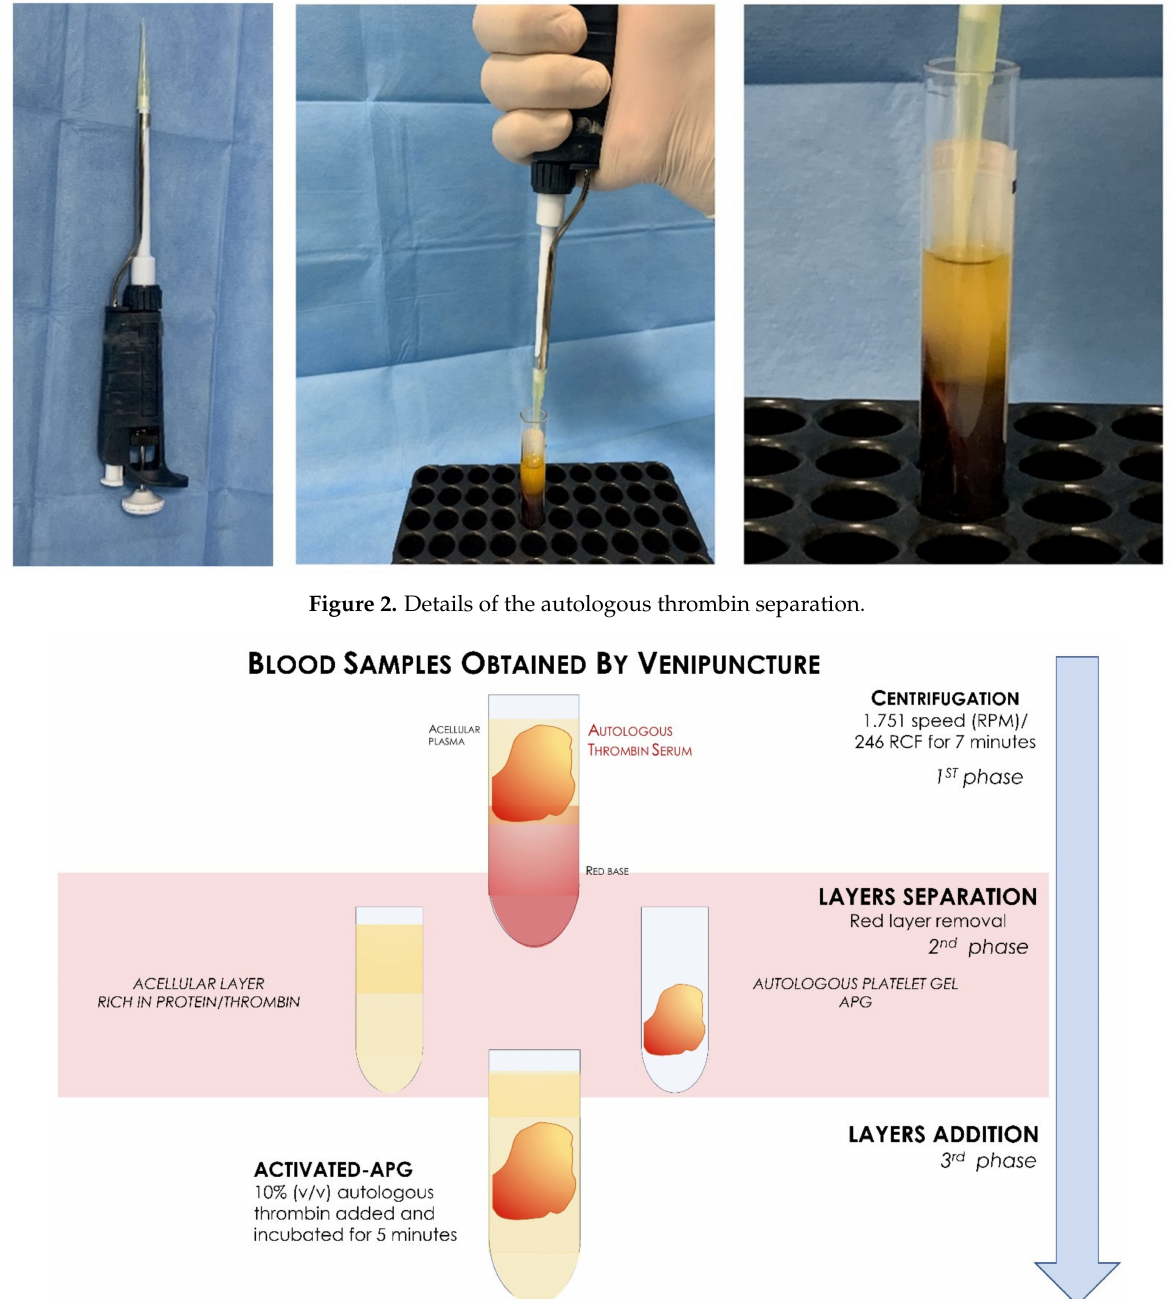
Figure 3. Flow chart of the activated APG formation